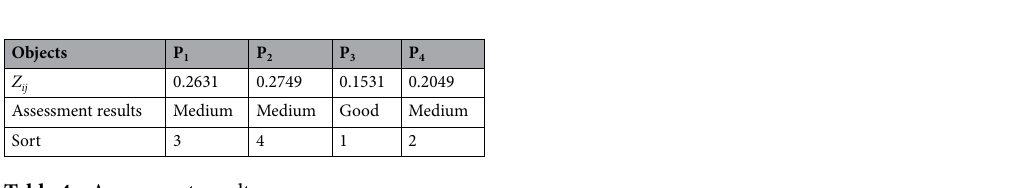
Table 4. Assessment